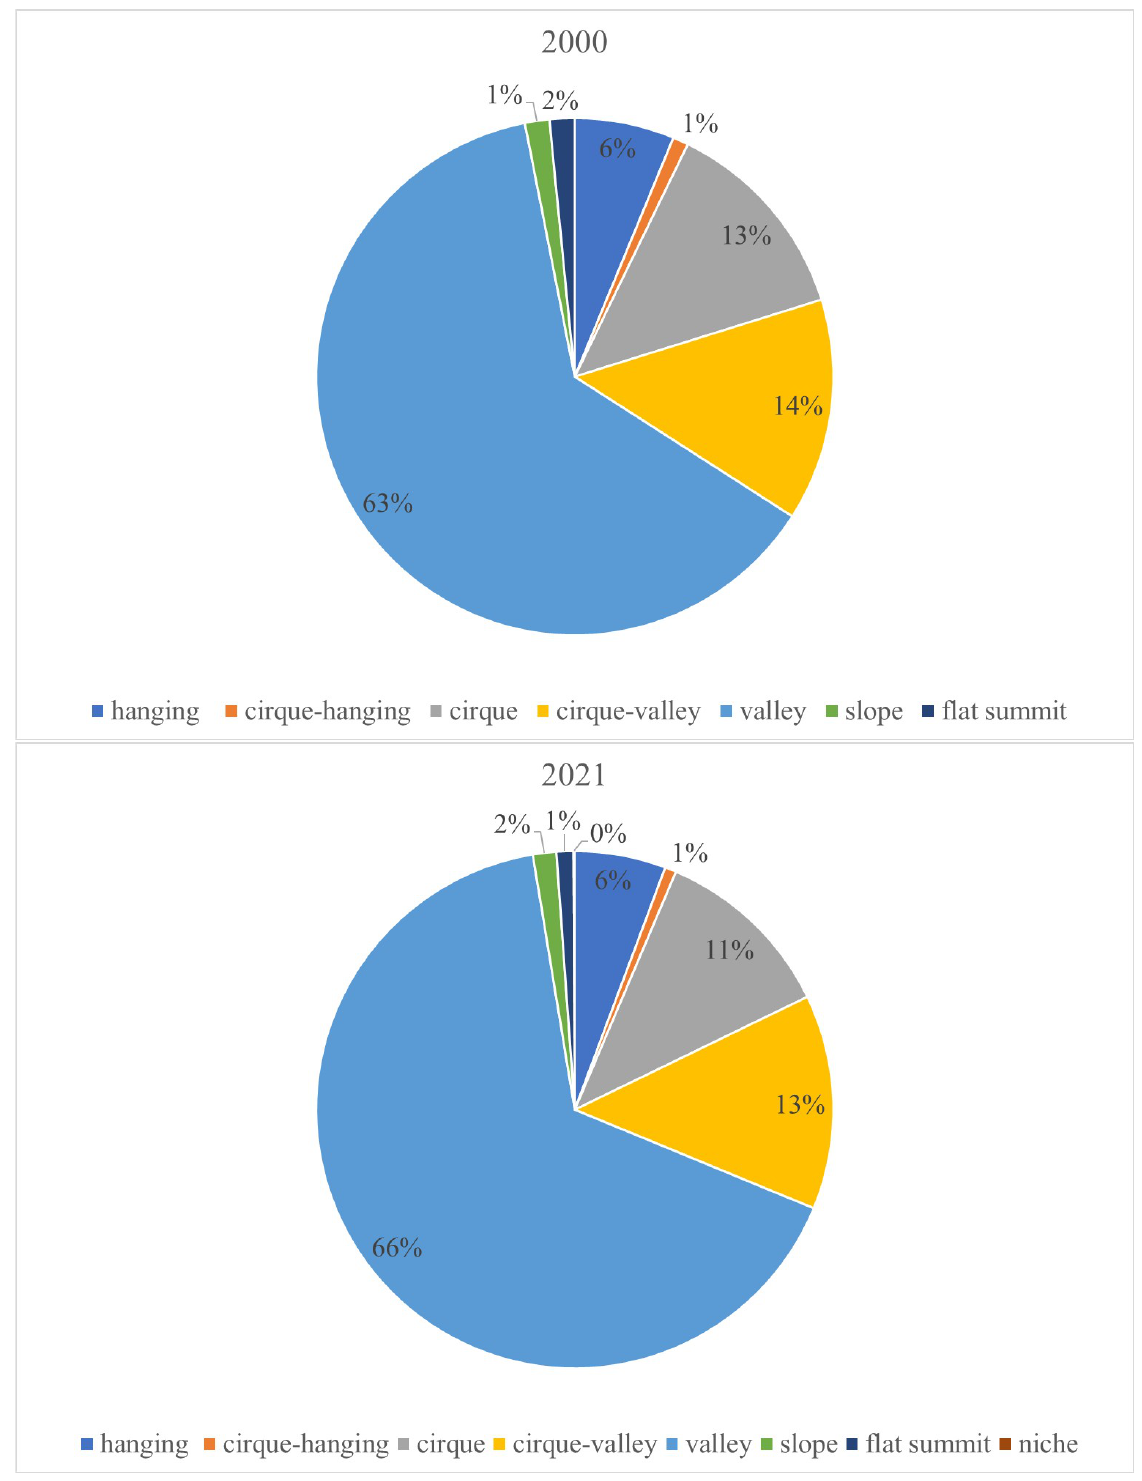
Figure 10. Proportion of total area of the glaciers of different morphological types from the LIA to